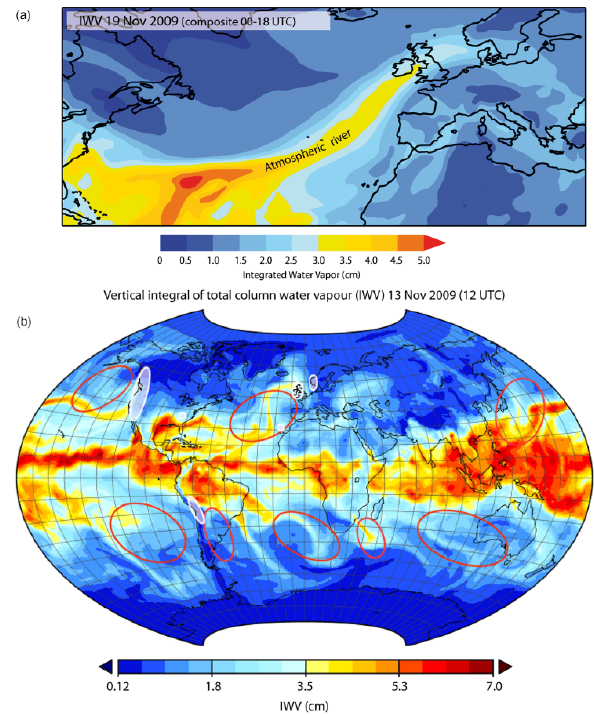
Figure 2. (a) Composite integrated total column of water va- por (IWV) between 00:00 and 18:00UTC on 19 November 2009 showing an atmospheric river (AR) associated with extreme precipi- tation events that affected the United Kingdom. Data: ERA-Interim. (b) A general distribution of areas of occurrence of ARs (red con- tours) based on Zhu and Newell (1998). White contours showed the continental areas where there are reported cases of ARs linked with extreme precipitation and floods (Fig. 1 in Gimeno et al., 2014; used with permission from Frontiers in Earth Science Editorial